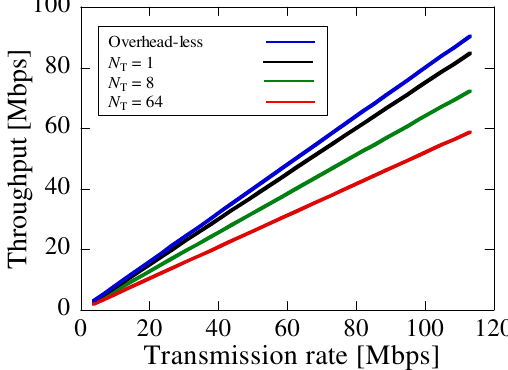
Figure 8. Transmission rate versus throughput from Equation (3).